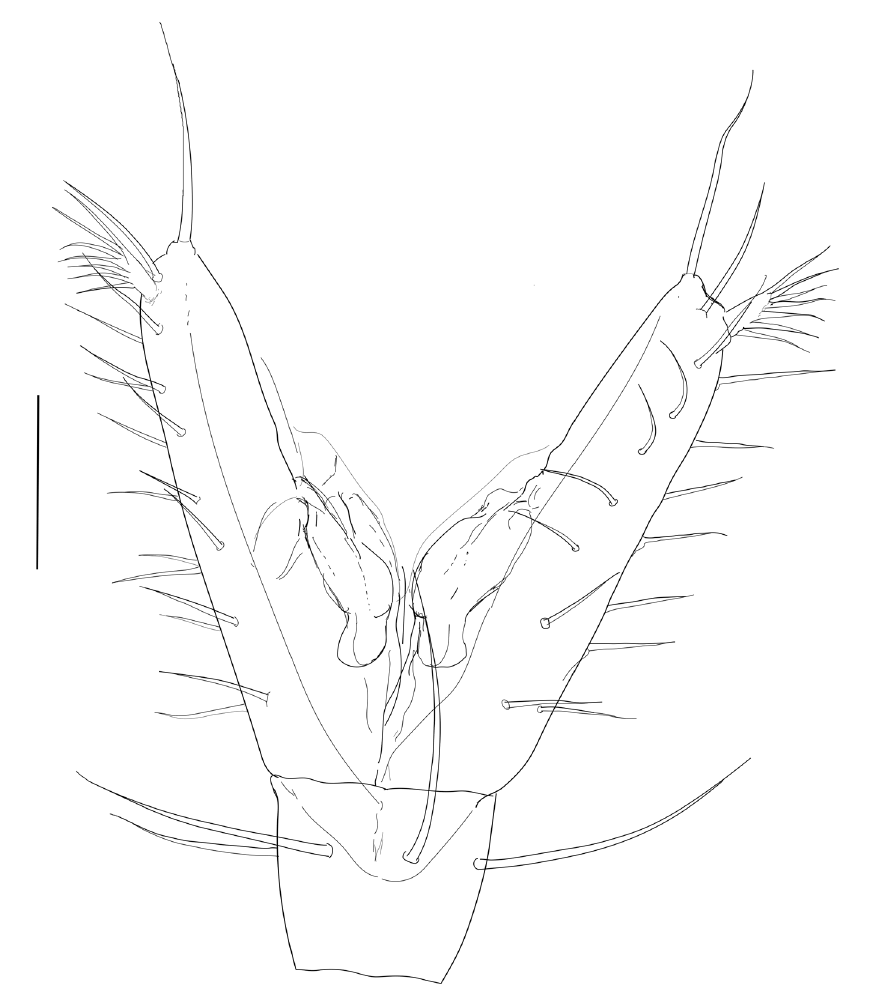
Fig. 10. Siro ozimeci Karaman sp. nov., holotype, ♀ ( GMV 100066). Distal portion of ovipositor, ventral view. Scale bar = 100